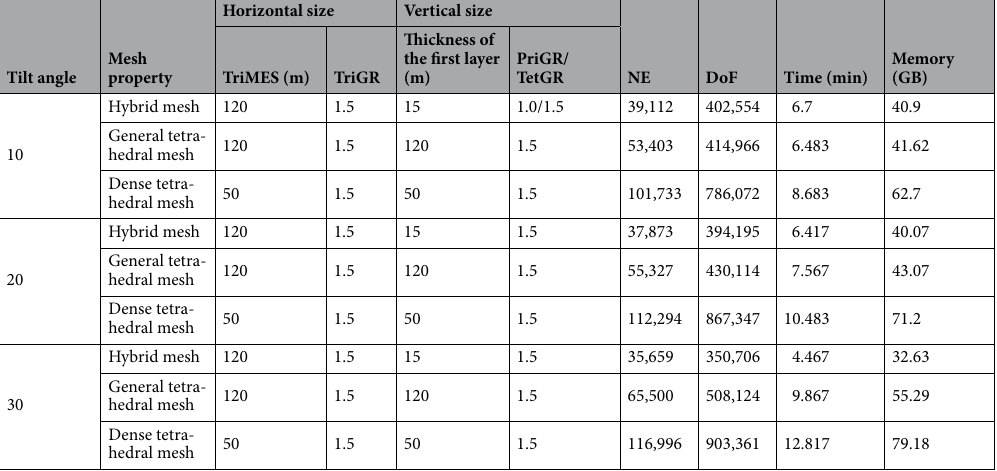
Table 4. Parameters of different meshes for the sloped terrain